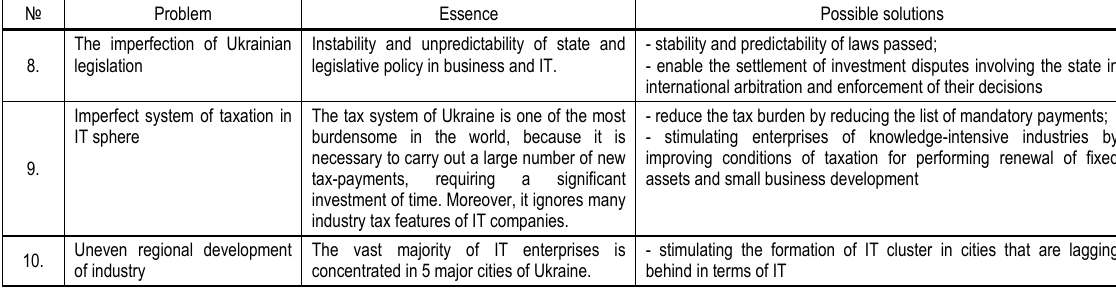
Table 2 (cont.). System problems in the development of IT sector in Ukraine and and their possible solutions № Problem